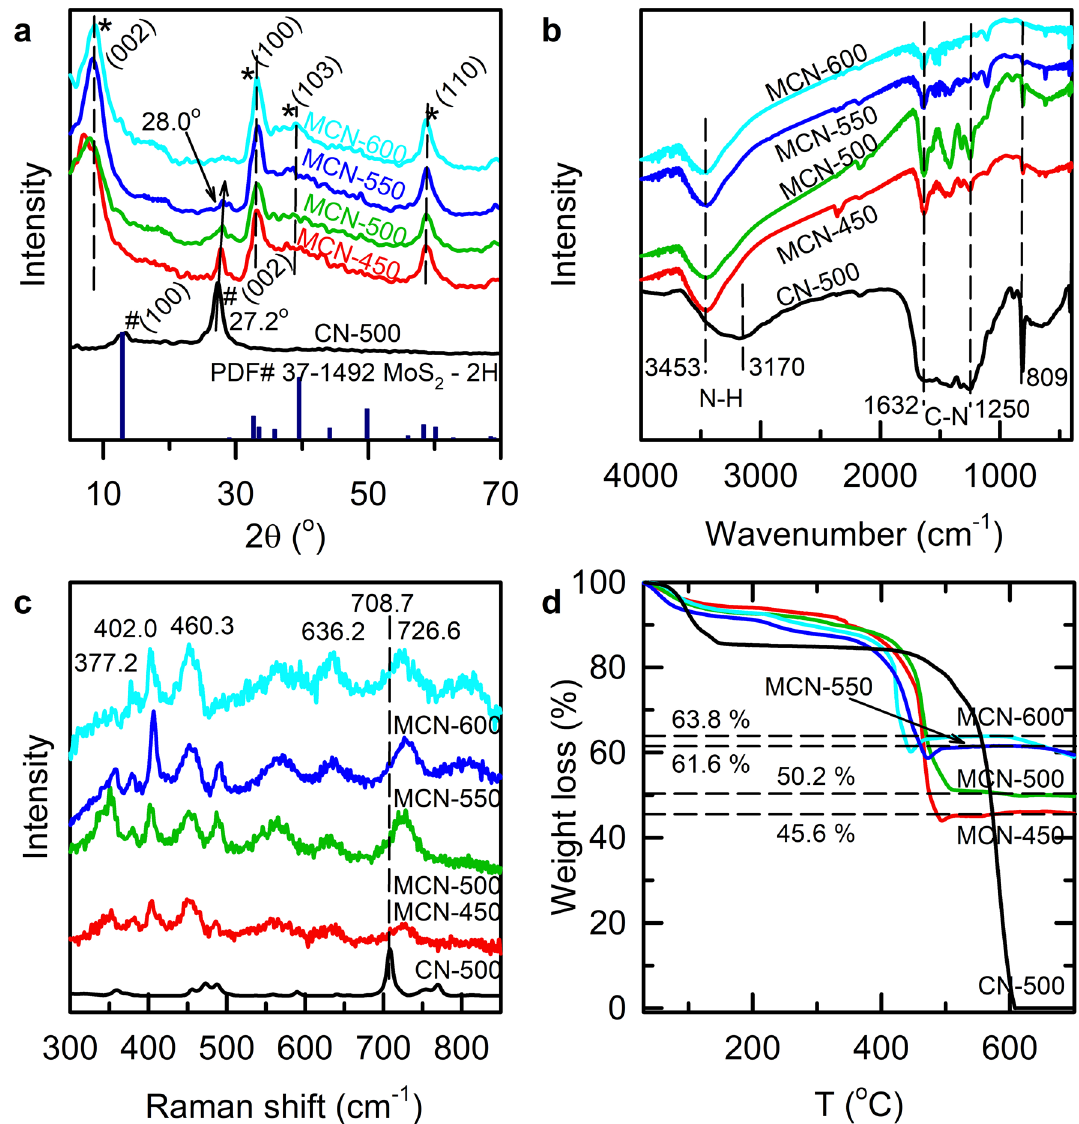
Figure 1. ( a ) XRD patterns; ( b ) FT-IR spectra; ( c ) Raman spectra; and ( d ) TG–DTA curves of CN-500, and MCN-T (T = 450, 500, 550, and